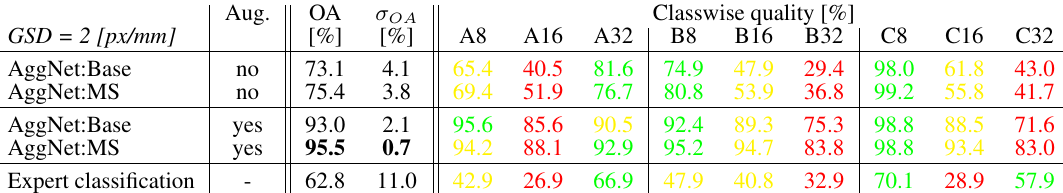
Table 1. Results for average OA and its standard deviation as well as for the classwise quality obtained for different settings of our proposed method (AggNet:Base and AggNet:MS), trained with and without data augmentation, as well as obtained from human expert classification. In all cases, a GSD of 2 [px/mm] was used. The colour coding distinguishes the three largest (green), lowest (red), and intermediate (yellow) values achieved for the quality of the indiviudal classes.